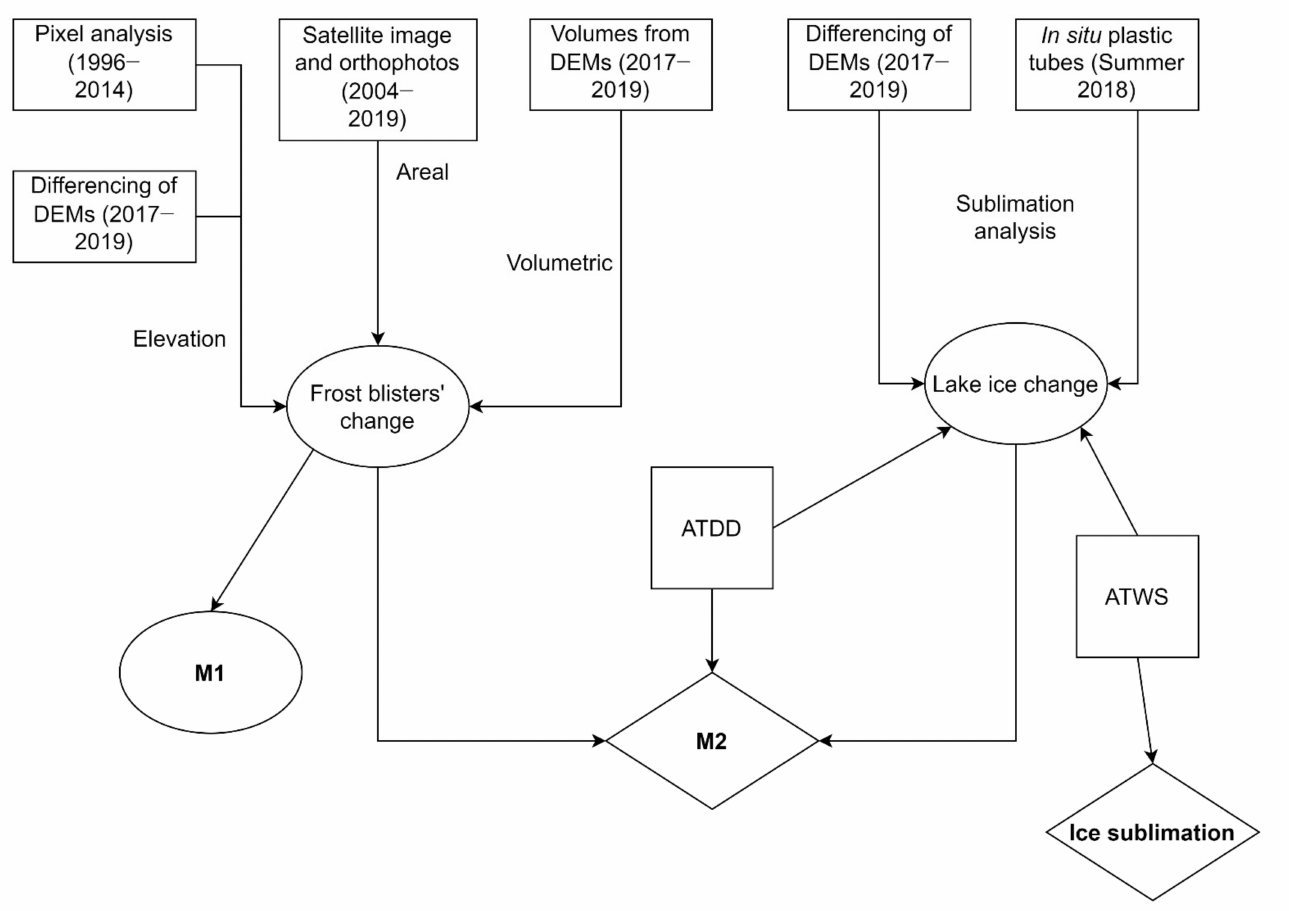
Figure 8. Flowchart of the methods and climatic parameters utilized in this paper. Input techniques with the reference period are presented as rectangles, while the derived results are showed as circles. Climatic indices that drive the frost blisters (M2) and ice level change (ATDD, ATWS) are shown as squares. Ice sublimation and ice level are correlated with climatic indices (ATWS for the former and ATDD for the latter). M2 changes are correlated also with both ATDD and ice level while M1 seems to be independent of climatic